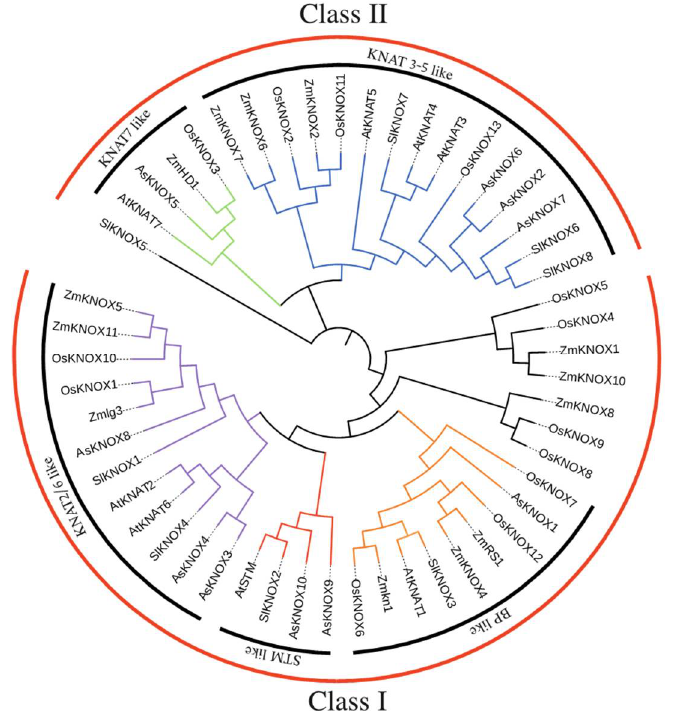
Figure 5. Interspecific phylogenetic tree of KNOX proteins from various species. A phylogenetic tree was constructed using the neighbor-joining method with bootstrap test (1000 iterations) by MEGA X.